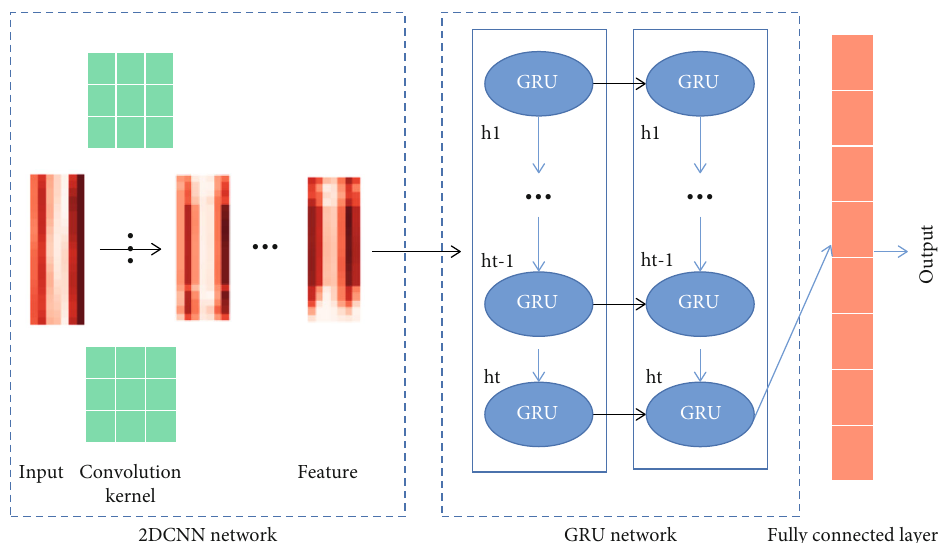
Figure 3: The structure of the 2DCNN-GRU hybrid network. A 2DCNN-GRU network is mainly composed of an input layer, a CNN Network, a GRU Network, and a fully connected